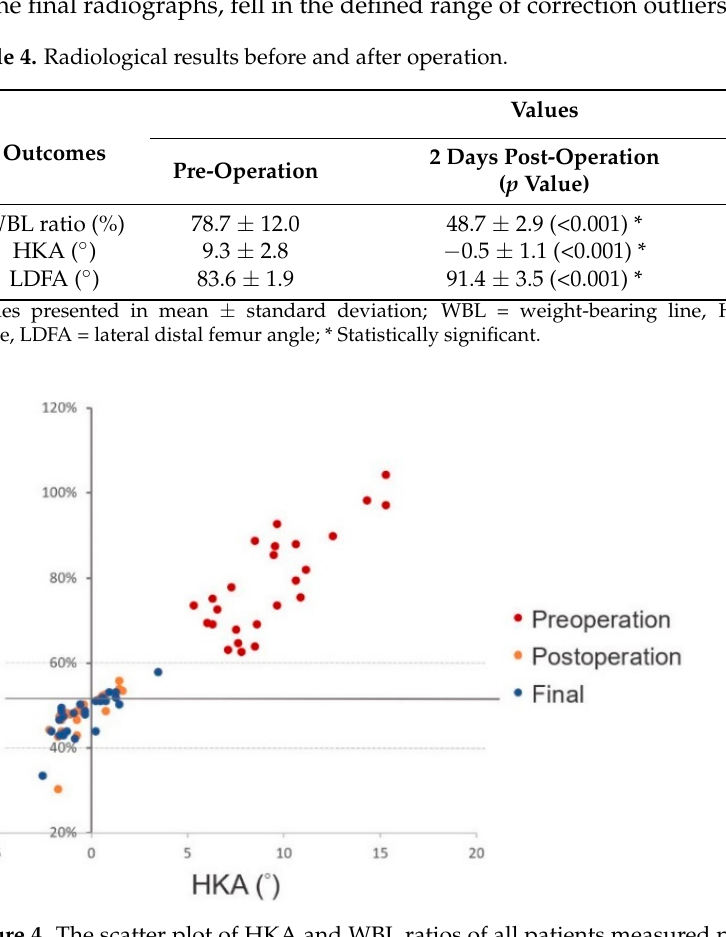
Table 3. Clinical and patient-rated outcomes before and after operation. Outcomes